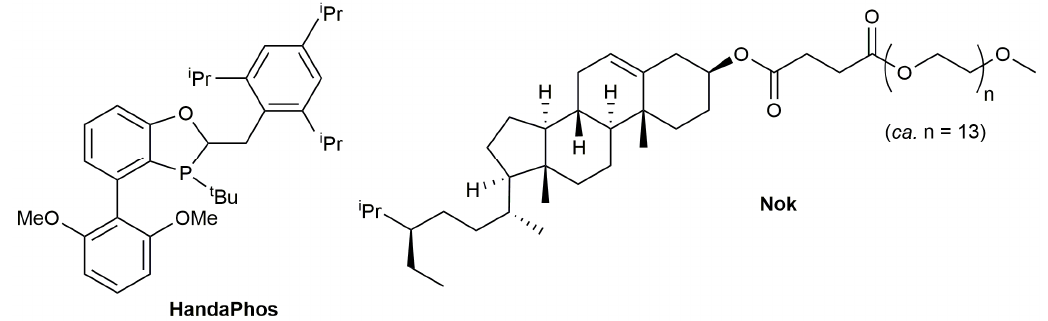
Figure 10. Structures of the phosphine ligand HandaPhos and the surfactant Nok.